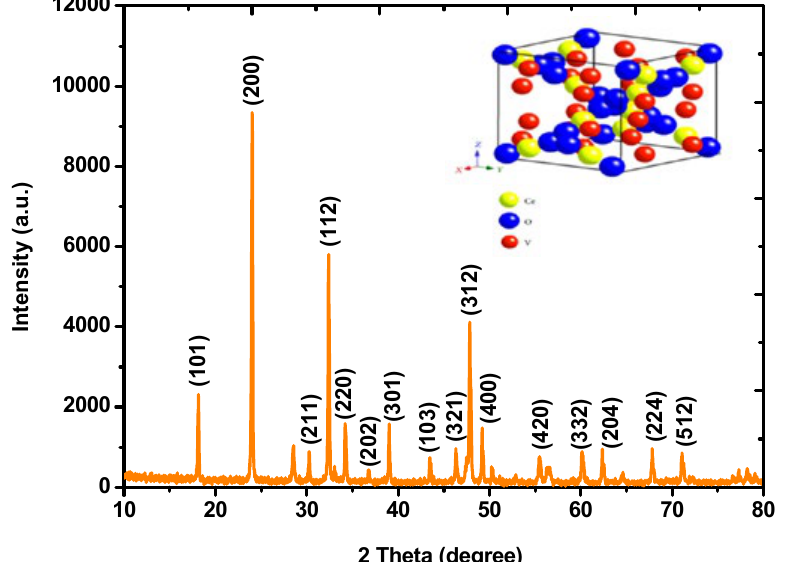
Fig. 2. X-Ray diffraction profile of the synthesized CeVO Fig. 2 X-Ray diffraction profile of the synthesized CeVO 4 NPs at room temperature